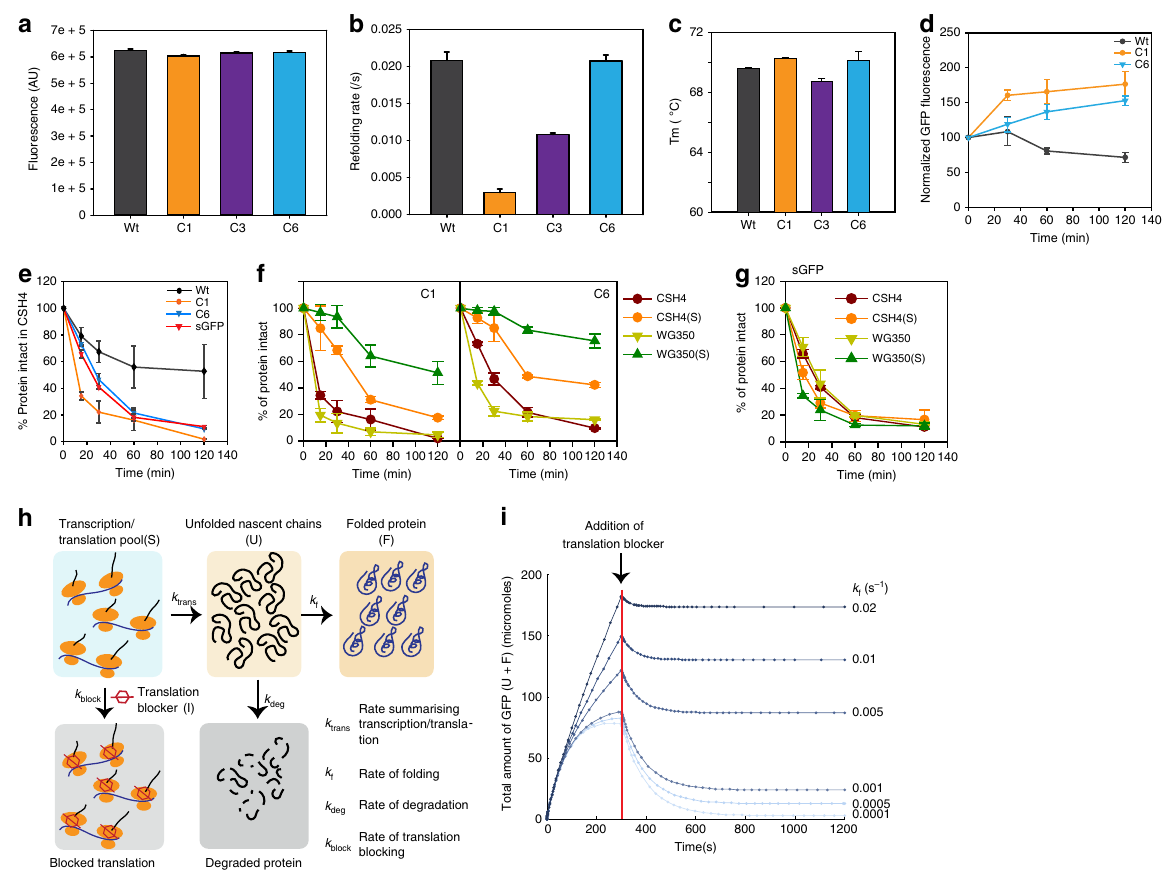
Fig. 4 Mutations buffered by altered metabolic states have compromised protein folding. a Fluorescence of Wt, C1, C3, and C6 GFP at 515 nm and 200 nM concentration. Mean is plotted with standard deviation as error bars from four biological replicates. b Mean of spontaneous refolding rates of Wt and GFP mutants in Buffer-A obtained by fi tting the refolding traces to single exponential equations. c Average (mean) melting temperature (Tm) calculated from thermal melts for Wt, C1, C3, and C6 GFP. d Mean of normalized GFP fl uorescence of Wt, C1, and C6 GFP at 0, 30, 60, and 120 min post- translation arrest with Chloramphenicol after 5 h induction of GFP in CSH4. e Mean of gel-based quanti fi cation of intact GFP in Chloramphenicol-chase assay of Wt and GFP mutants in CSH4. f Mean of gel-based quanti fi cation of intact GFP in Chloramphenicol-chase assay of C1 and C6 GFP in CSH4, CSH4(S), WG350, and WG350(S). g Mean of gel-based quanti fi cation of intact GFP in Chloramphenicol-chase assay of sGFP in CSH4, CSH4(S), WG350, and WG350(S). h Schematic for numerical simulation with a fi xed concentration of mRNA/ribosome complex (S). These complexes could either form nascent polypeptides (U) with rate k trans (collective rate constant for transcription/translation), or inhibited with rate constant k block in presence of a translation inhibitor (I). The pool U could either degrade with rate k deg or fold with rate constant of k f and reach the native state (F). Total amount of undegraded protein (U + F) after blocking translation was monitored after 300 s of starting the simulation (start of simulation mimics induction). i Total amount of intact GFP obtained from simulation as a function of k f keeping k deg constant at 0.01 s − 1 . Red line indicates the time-point at which 1 mM of translation inhibitor (I) is added. For b , c , d , e , f , and g : Standard deviations are plotted as error bars from 3 biological replicates. Also see Supplementary Fig. 3 (Source data are provided as source data fi le Fig.